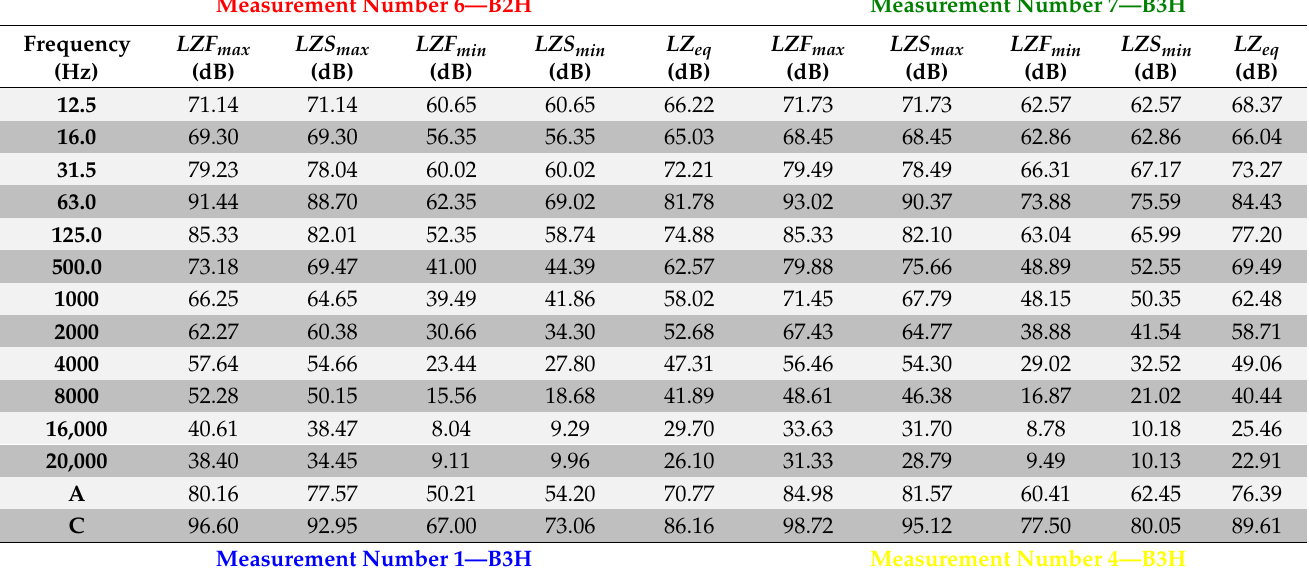
Table 7. Values of noise levels in the 1/3 octave frequency spectrum band in B2H and B3H of selected